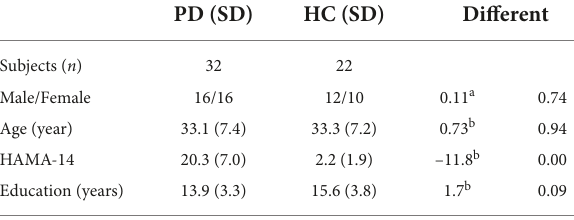
TABLE 1 Demographic and clinical characteristics of total samples.